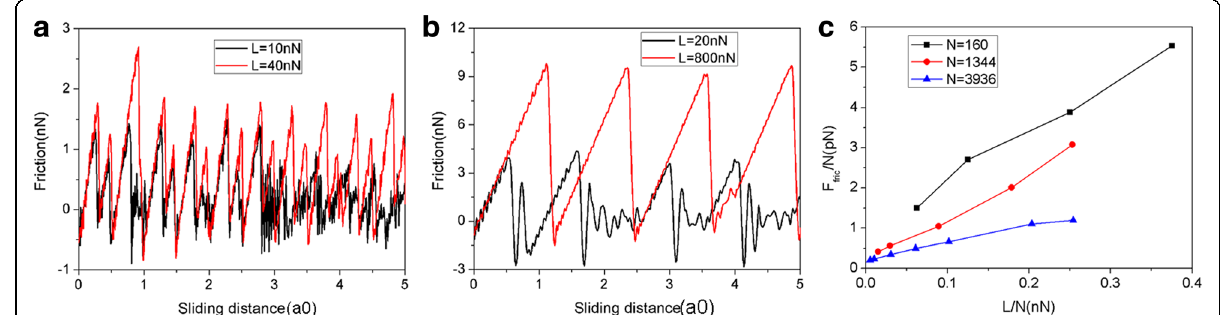
Fig. 11 The variation of friction force and average friction force for different flake sizes for the friction process without the movement constraint of graphene in the y direction. The typical friction force as a function of sliding distance for the 2.0 nm ( N = 160 atoms) flake ( a ) and 10 nm ( N = 3936 atoms) flake ( b ). c The average friction force per atom ( F fric /N) as a function of load per atom (L/N). Here, a0 (= 9.99 Å) is the lattice spacing of Au(111) along the sliding direction